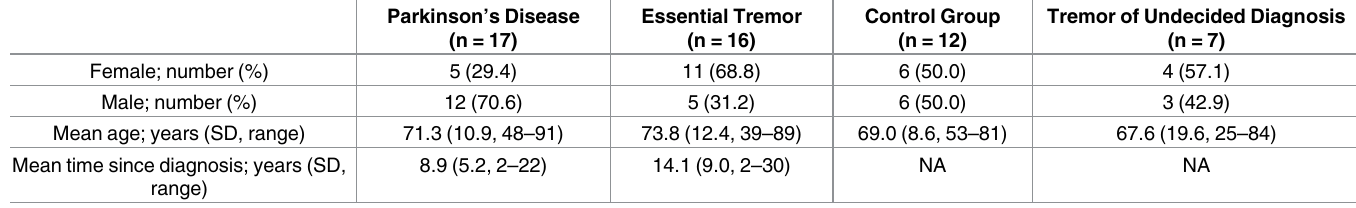
Table 1. Demographic characteristics of the subjects studied (n =